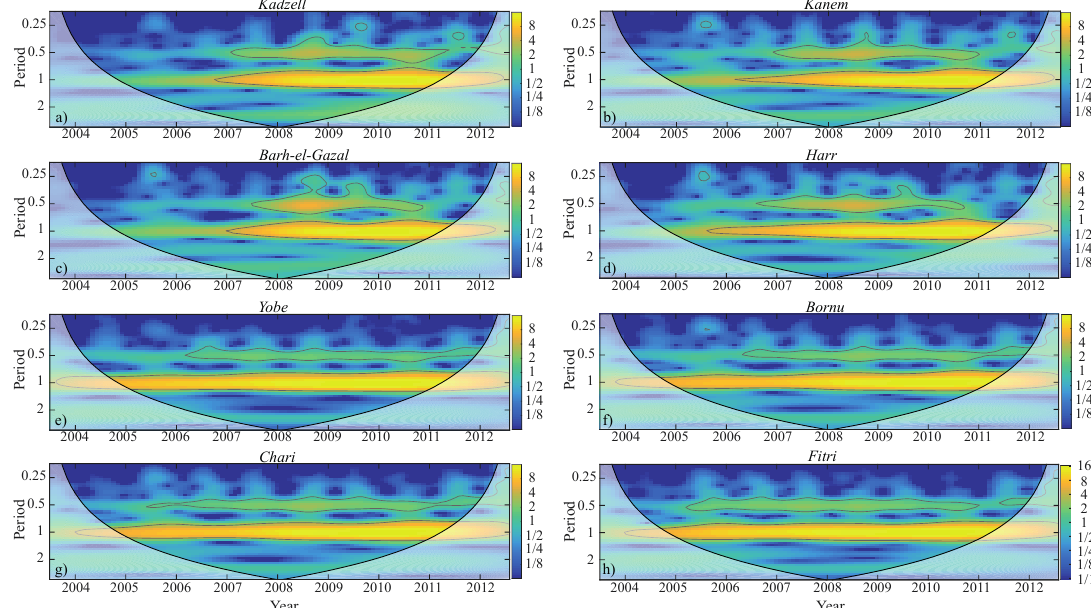
Figure 13. Cross-wavelet transform (XWT) of the ET rate and GRACE water was signals. The x -axis represents the time. The y -axis is the time converted to its equivalent Fourier period: it represents 2 years; 1 year; and 6, 3, and 1 1 months. The color scale represents cross-wavelet energy. The warm 2 color represents the higher degree of dependence between the signals. The COI (i.e., region affected by edge effects) is represented as a lighter zone. Black thin contours highlight the 95% confidence